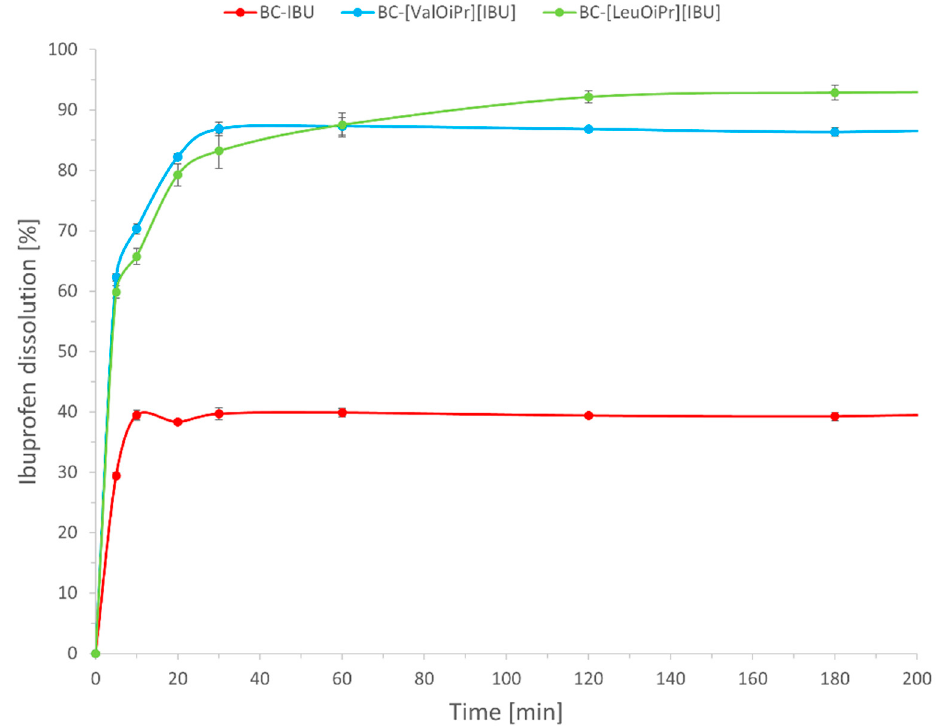
Figure 4. Dissolution profiles of BC-IBU, BC-[ValOiPr][IBU] and BC-[LeuOiPr][IBU]. Mean values n = ± standard deviation, n = 3.